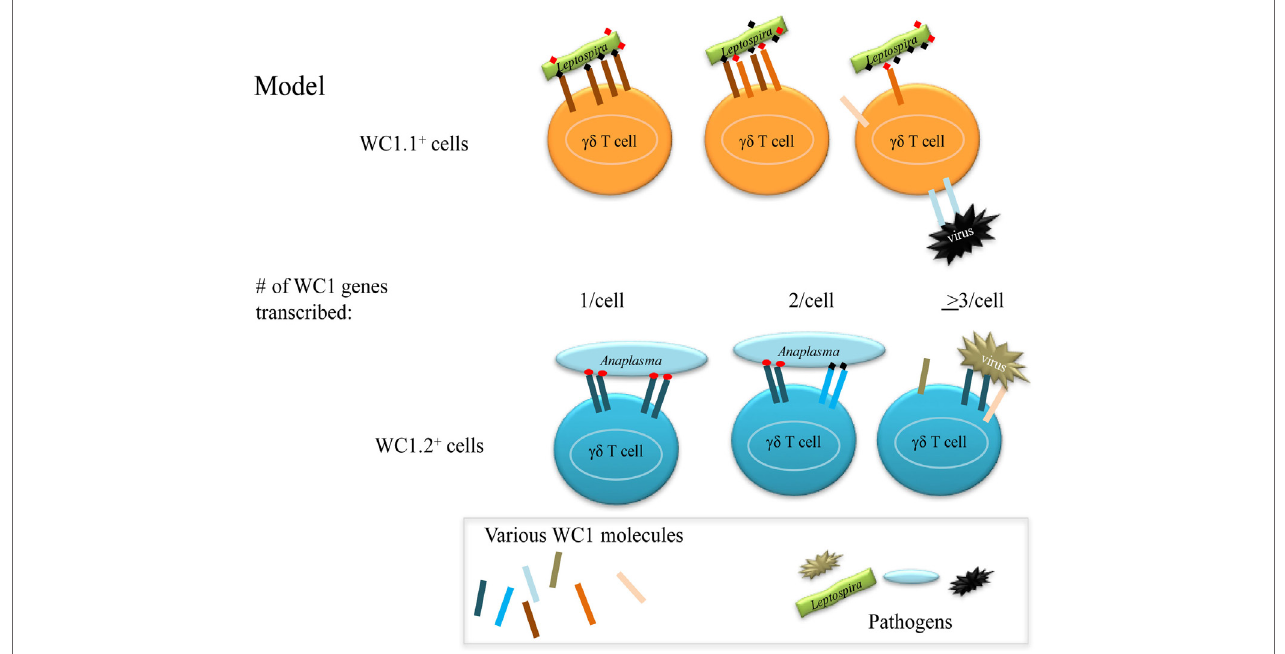
FigUre 7 | Model for WC1 interaction with pathogens. γδ T cells may express variable numbers of different WC1 molecules thus potentially enabling them to interact with more than one ligand on the same or different pathogens. However, since the number of WC1 co-receptors is necessarily limited on a cell an increase in receptor diversity could affect the avidity of the interaction with any particular